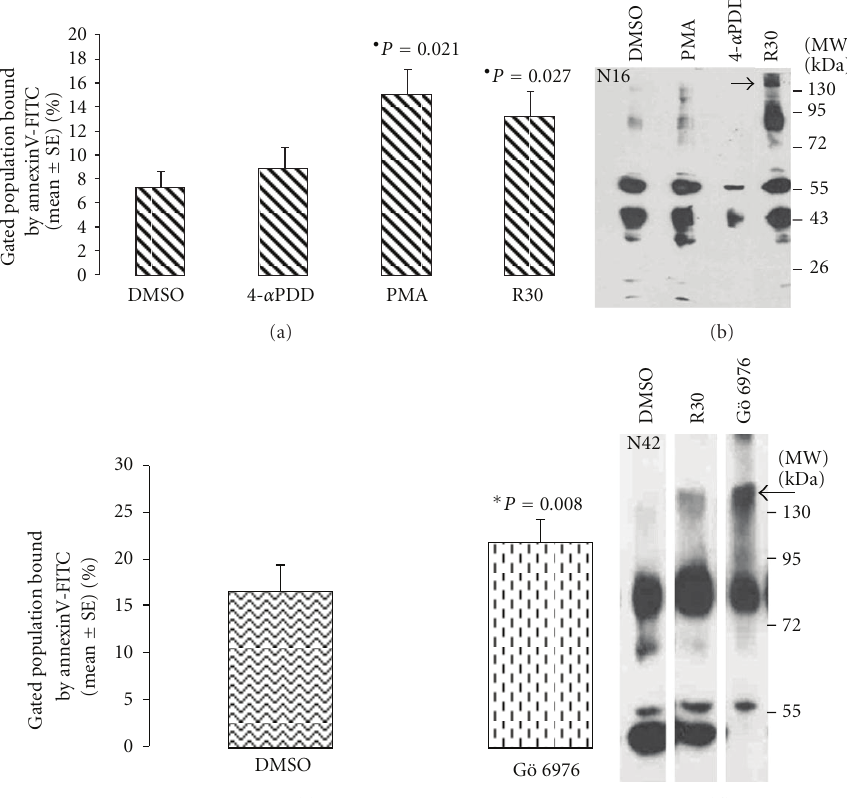
Figure 1: Externalization of PS and aggregation of band 3 induced by PKC α activator (PMA) and inhibitors (30 μ M rottlerin-R30 and G¨o 6976). Flow cytometry of annexinV-bound cells shows significant ( ∗ ) increased percentage of cells with externalized PS upon treatment with (a) PMA, R30 (Wicoxon signed rank test; n = 10) as well as (c) with G¨o 6976(paired t -test, n = 10). A signal for aggregated band 3 above 130kDa (indicated by arrow) is seen in western blot of erythrocyte membrane proteins immunostained with band 3 antibody only in cells treated with (b) R30 (represented in sample N 16) and (d) G¨o 6976 (represented by N